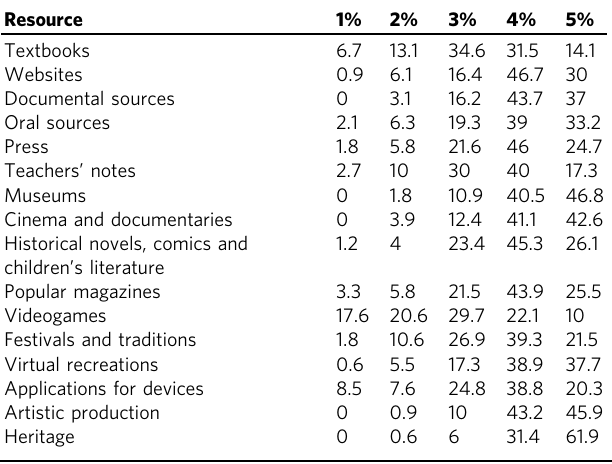
Table 4 Results of the descriptive analysis of resources.